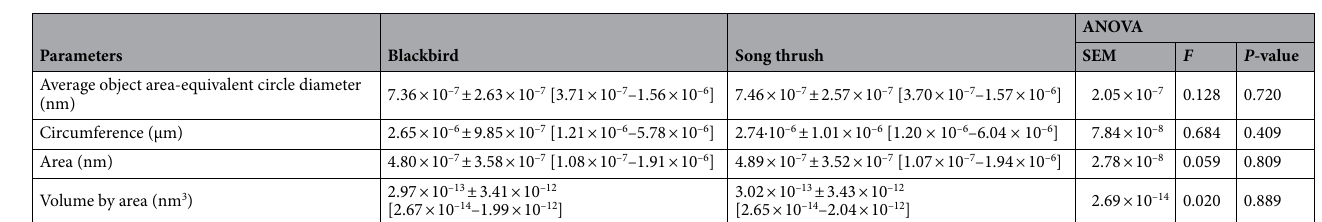
Table 1. Ultrastructure parameters of blackbird and song thrush eggshell determined using PoroMetric with Phenom scanning electron microscope. Values are means and errors for 10 eggshells of blackbird and 10 eggshells of song thrush (each for different egg). Statistically significant at P <